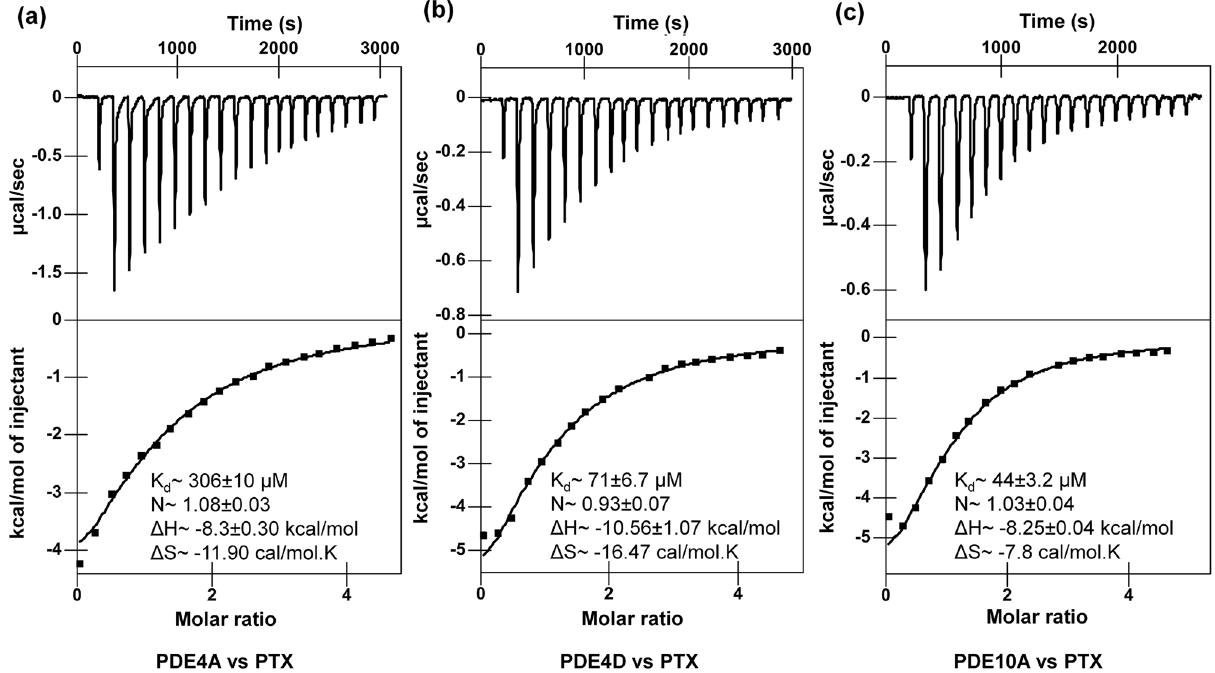
Figure 1. Raw ITC data (upper panel) and normalized integration data (lower panel) for binding of PTX to PDEs. ITC plots for the binding of PTX to ( a ) PDE4A ( b ) PDE4D and ( c ) PDE10A. The inset lists the measured